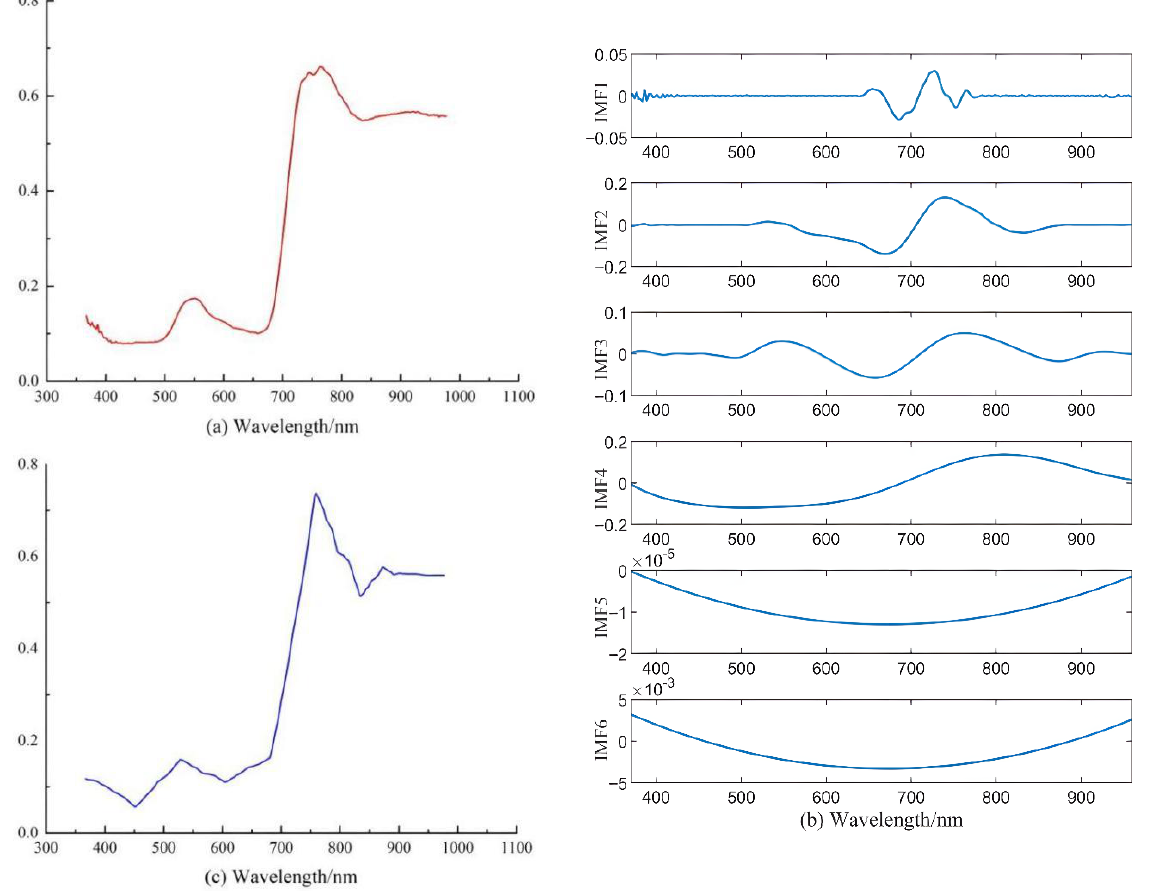
Figure 3. Denoising process of sample 1, old leaf, based on EEMD-db3: ( a ) original spectral curve; ( b ) the result of EMD decomposition; ( c ) spectral curve after EEMD-db3 denoising.